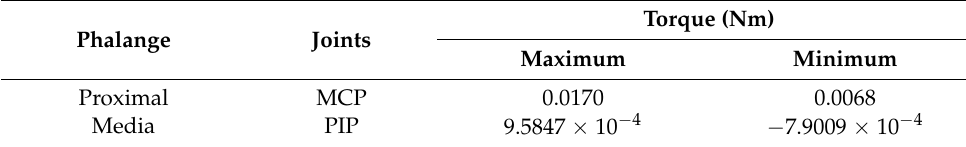
Table 6. Torque for each phalange.